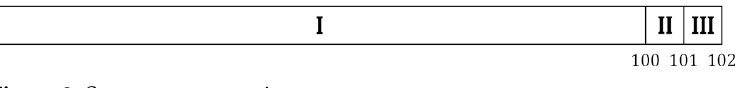
Figure 3. State vector